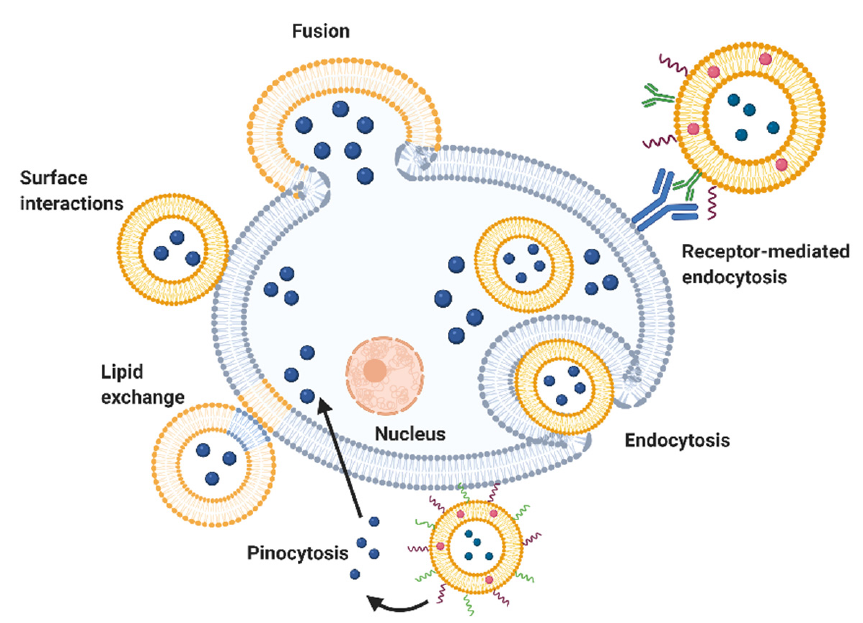
Figure 3. Mechanisms of liposomes uptake into cells. Liposomes can deliver their content into cells through various mechanisms including lipid exchange, surface interactions, fusion, endocytosis, and pinocytosis.